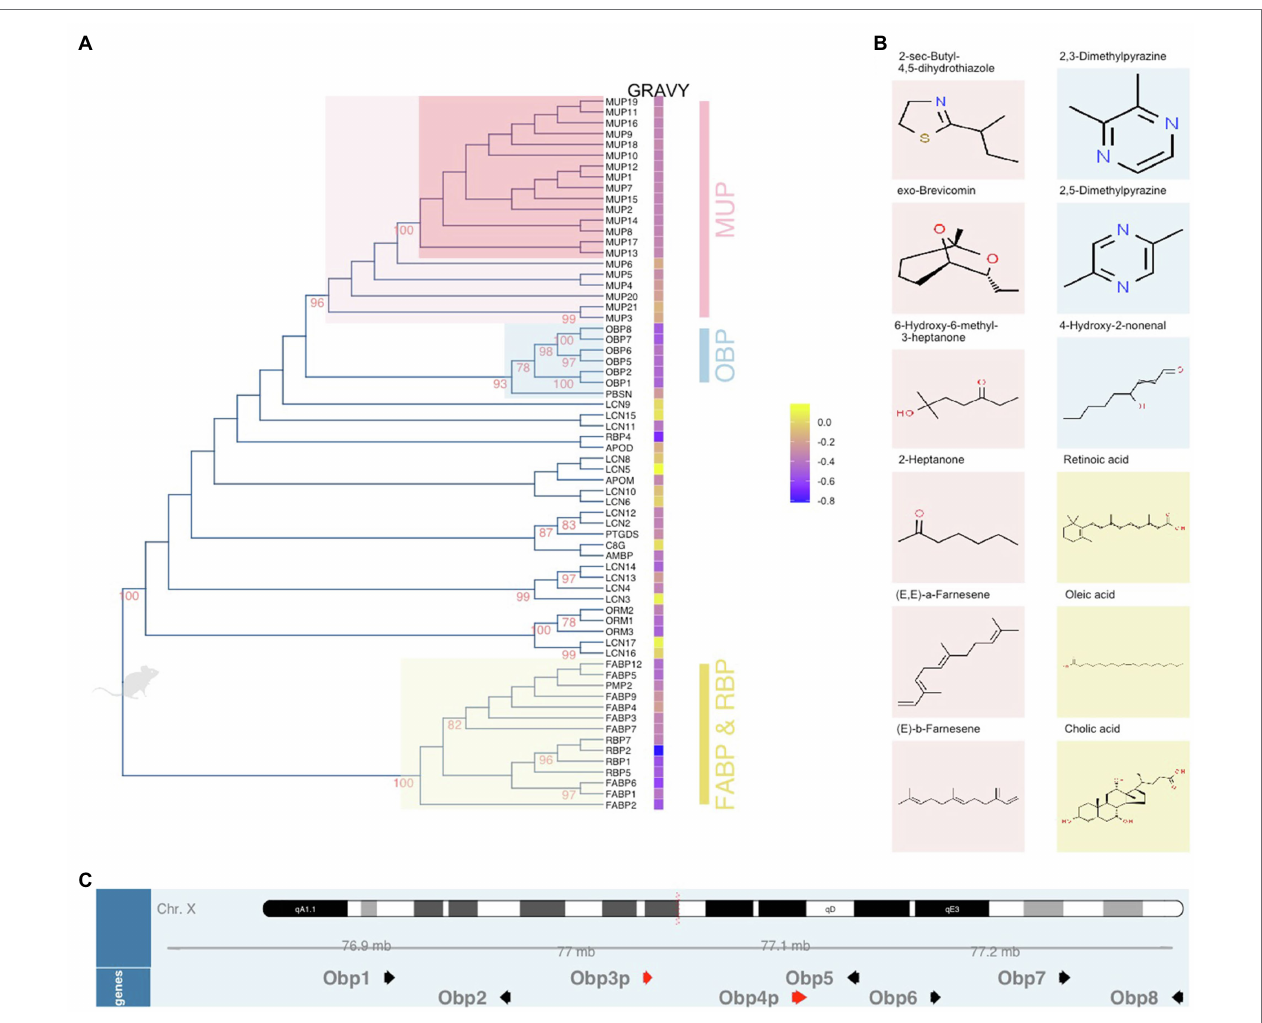
FIGURE 1 | Unrooted dendrogram of mouse lipocalins within the Calycin superfamily. The evolutionary history was inferred by using the Maximum Likelihood method based on the JTT matrix-based model. The tree (A) with the highest log likelihood ( − 17,639.2427) is shown. The percentage of trees in which the associated proteins clustered together is shown next to the branches. Initial tree(s) for the heuristic search were obtained by applying the Neighbor-Joining method to a matrix of pairwise distances estimated using a JTT model. The tree is drawn to scale, with branch lengths measured in the number of substitutions per site. The analysis involved 66 amino acid sequences. There were a total of 406 positions in the final dataset. Evolutionary analyses were conducted in MEGA6 while the final figure was plotted with ggtree . Next to the tree, Gravy index is scaled from blue (hydrophilic) to yellow (hydrophobic). The colour code of highlighted subtrees is also used (B) to highlight the most common ligands with high affinities to particular protein groups. The position of Obp genes (black arrows) and pseudogenes (red arrows) on the X chromosome is visualized in (C) using Gviz Bioconductor